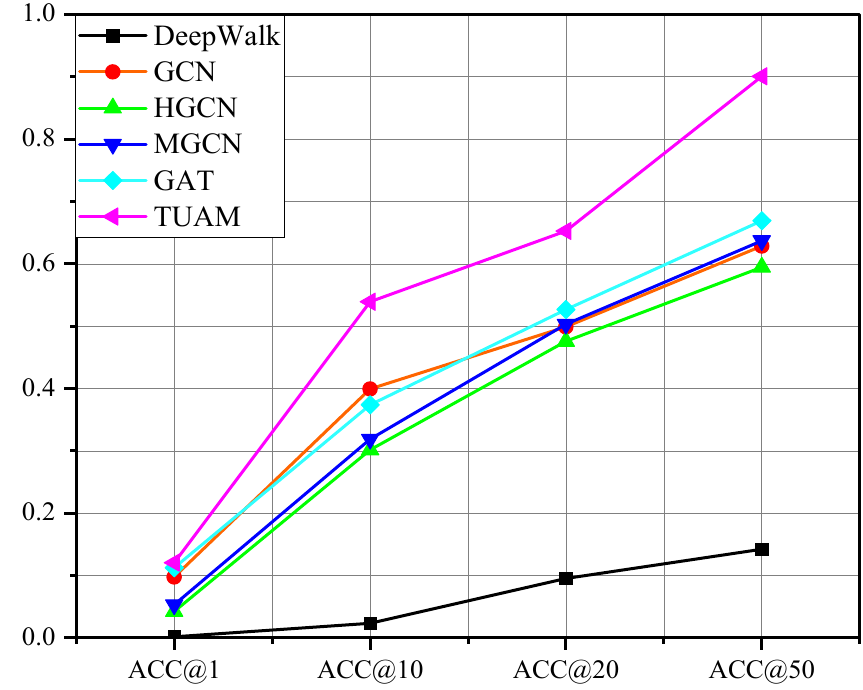
Figure 2. The accuracy of several models on the Facebook–Twi tt er dataset.